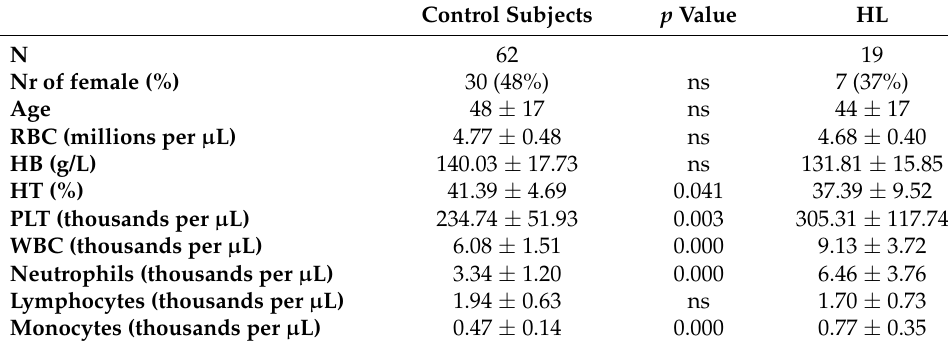
Table 1. Demographic and hematologic